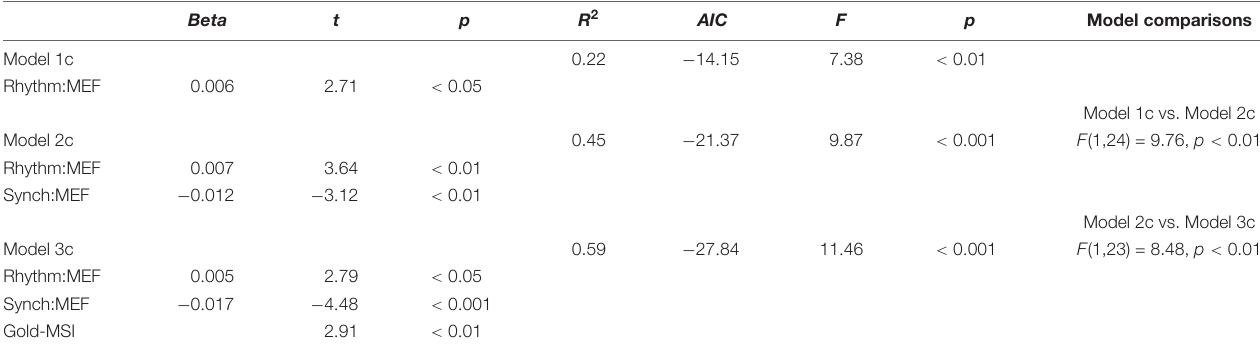
TABLE 8 | Summary and comparisons between Models 1c, 2c, and 3c predicting phonological